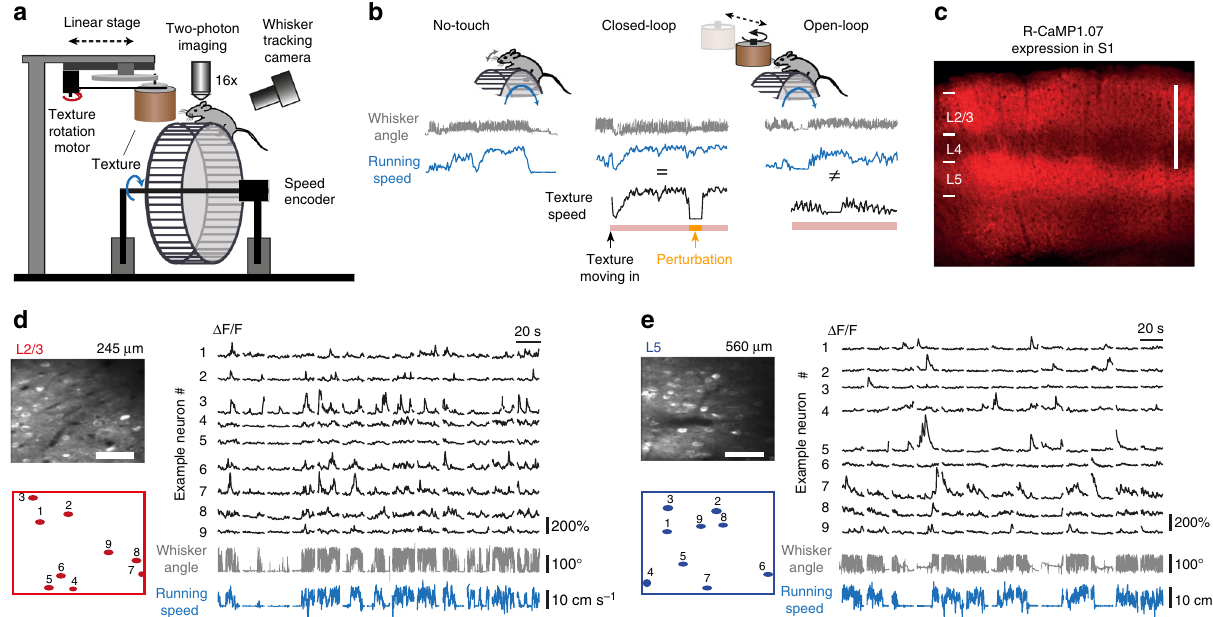
Fig. 1 Calcium imaging in L2/3 and L5 of mouse barrel cortex during various running and whisking conditions. a Schematic of virtual reality setup with a head-restrained mouse on top of a rung-ladder treadmill. A sandpaper-covered cylinder (texture) can be moved in contact with the whiskers. Run speed is tracked with an encoder and the mean whisker angle is monitored with a high-speed video camera. b Example traces of whisker angle (gray), run speed (blue), and texture-rotation speed (black), illustrating the three experimental conditions: ‘ No-touch ’ , ‘ Closed-loop ’ , and ‘ Open-loop ’ . The pink bottom bar indicates when the texture contacts the whiskers. The orange segment highlights the intermittent halt of texture-rotation to introduce a brief perturbation period in Closed-loop trials by uncoupling run speed and texture speed. c Confocal image of virally-induced R-CaMP1.07 expression pattern in a coronal slice of somatosensory cortex of a wild-type mouse. Scale bar is 500 µ m. d Left: In vivo two-photon image of R-CaMP1.07-expressing L2/3 neurons with selected ROIs below (scale bar, 50 µ m). Right: Δ F / F calcium transients of nine example neurons with simultaneously recorded mean whisker angle (gray) and running speed (blue) below. e Same as in ( d ) but for example L5 neurons in